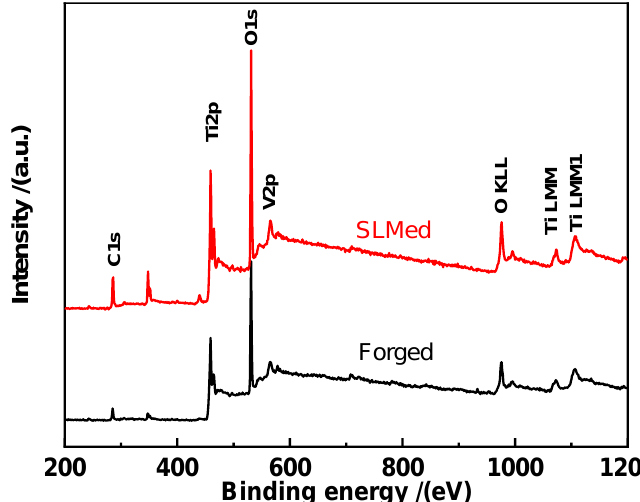
Figure 9. XPS analysis of passivation films on two Ti-6Al-4V alloys.